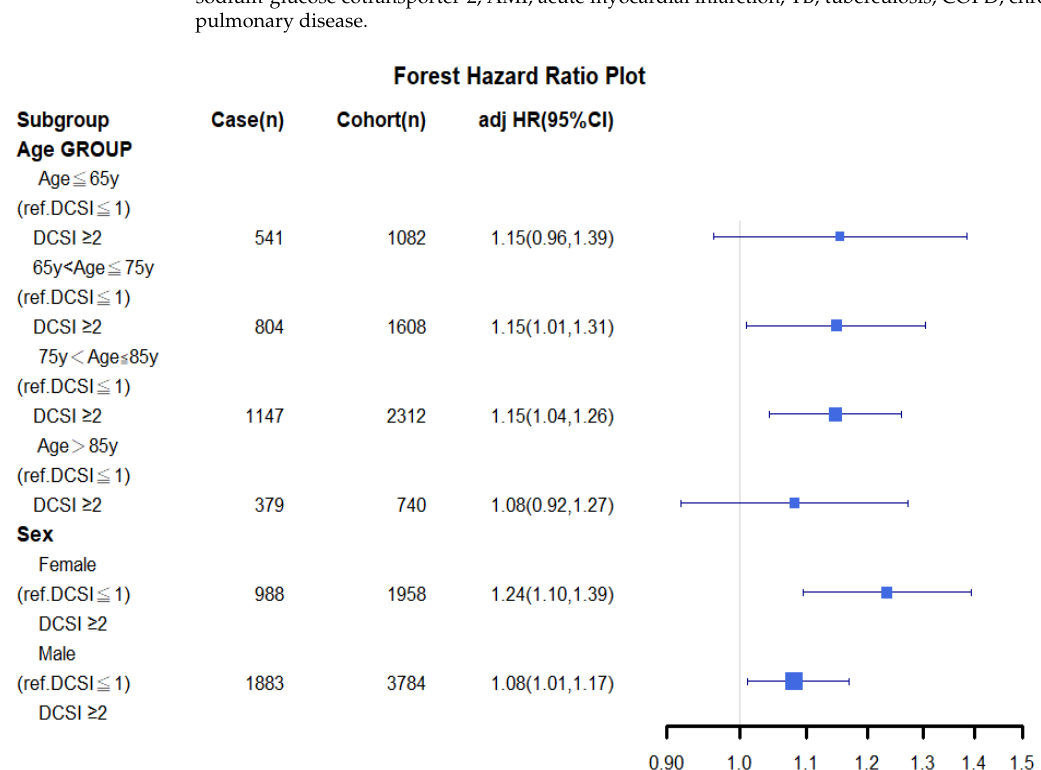
Figure 1. Sensitivity analysis of sex- and age-stratified groups (using inverse probability of treatment weighting) for all-cause death in patients with both lung squamous cell carcinoma and mild or moderate-to-severe diabetes. Abbreviations: aHR, adjusted hazard ratio; y, years; aDCSI, adapted Diabetes Complications Severity Index; CI, confidence interval; ref., reference